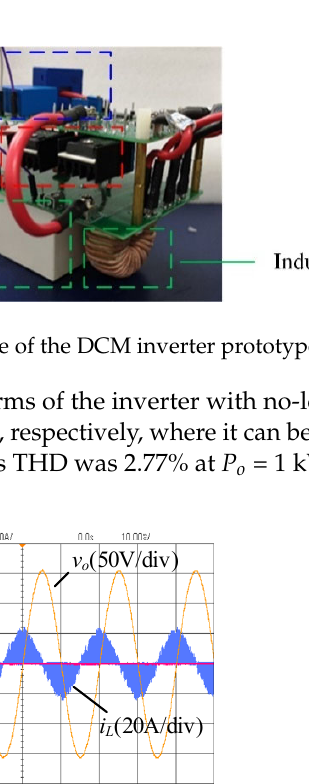
Figure 11. The voltage and current waveforms of the DCM inverter at P o = 1 kW. Time: 10 ms/div. The zoomed ‐ in waveforms of Figure 11 at different output voltage values, including v o = 0 and 150 V, are illustrated in Figure 12. The drain ‐ source voltage of active switch V Q 1 and inductor current i L for DCM operation is illustrated in Figure 12, where the output voltage v o and output current io are also given as a reference. As shown in Figure 12, the active switch was always under ZCS turn ‐ on. What is more, the oscillating waveforms on i L and V Q1 were due to the resonance caused by the inductor and the parasitic capacitance of the switching devices in the corresponding interval in which both switches were turned off. As shown in Figure 13, when the step load was applied, the voltage sag was 25.5 V, and the corresponding drop time was 0.4 ms, which was about four switching periods. In Figure 13, it can be seen that the proposed DCC method had good dynamic performance while using the proportional feedback controller plus the proportional load current feed ‐ forward controller. It should be noted that PID control, PR control, and other control methods can also be easily adopted in the proposed method if higher performance is re ‐ quired, but due to the limitation on the paper length, this is not discussed in this paper. Furthermore, although the inductor current maximum value of the inverter under no load and under the resistive load were similar, the duty cycles were different, as given in Equa ‐ tion (12). Under very small Q L and d , the conduction losses in the no ‐ load situation were much smaller than those in the full ‐ load situation. v o (50V/div) i o (5A/div)